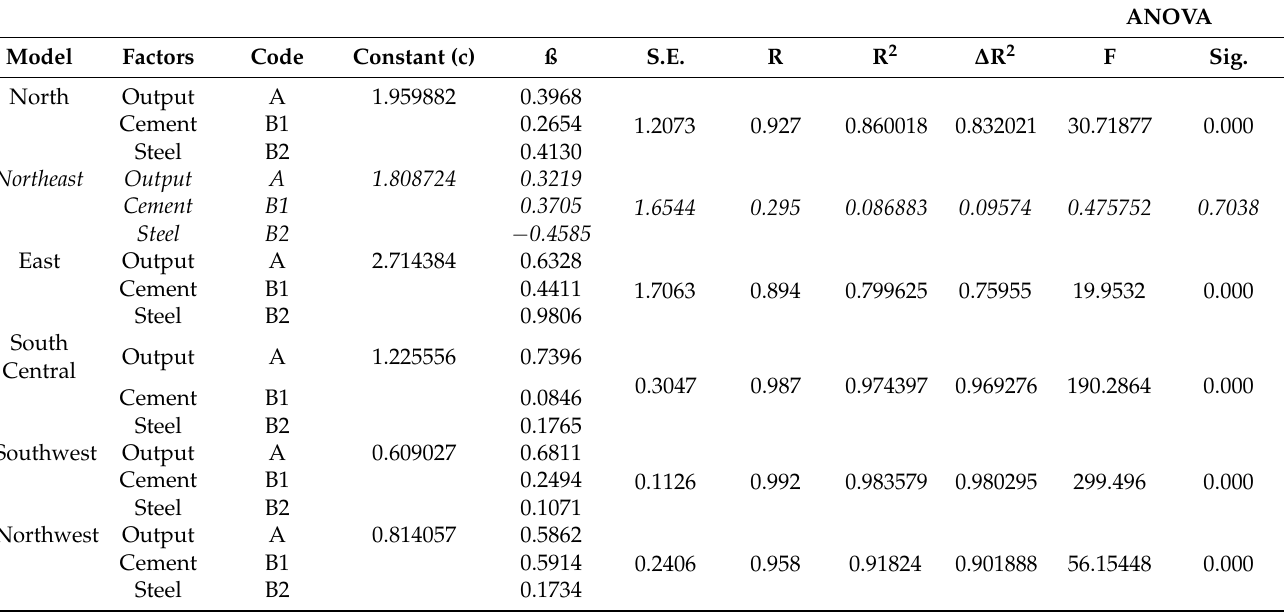
Table 8. EcoF–RDCO2 direct CO 2 emission regression model in China’s construction sector.